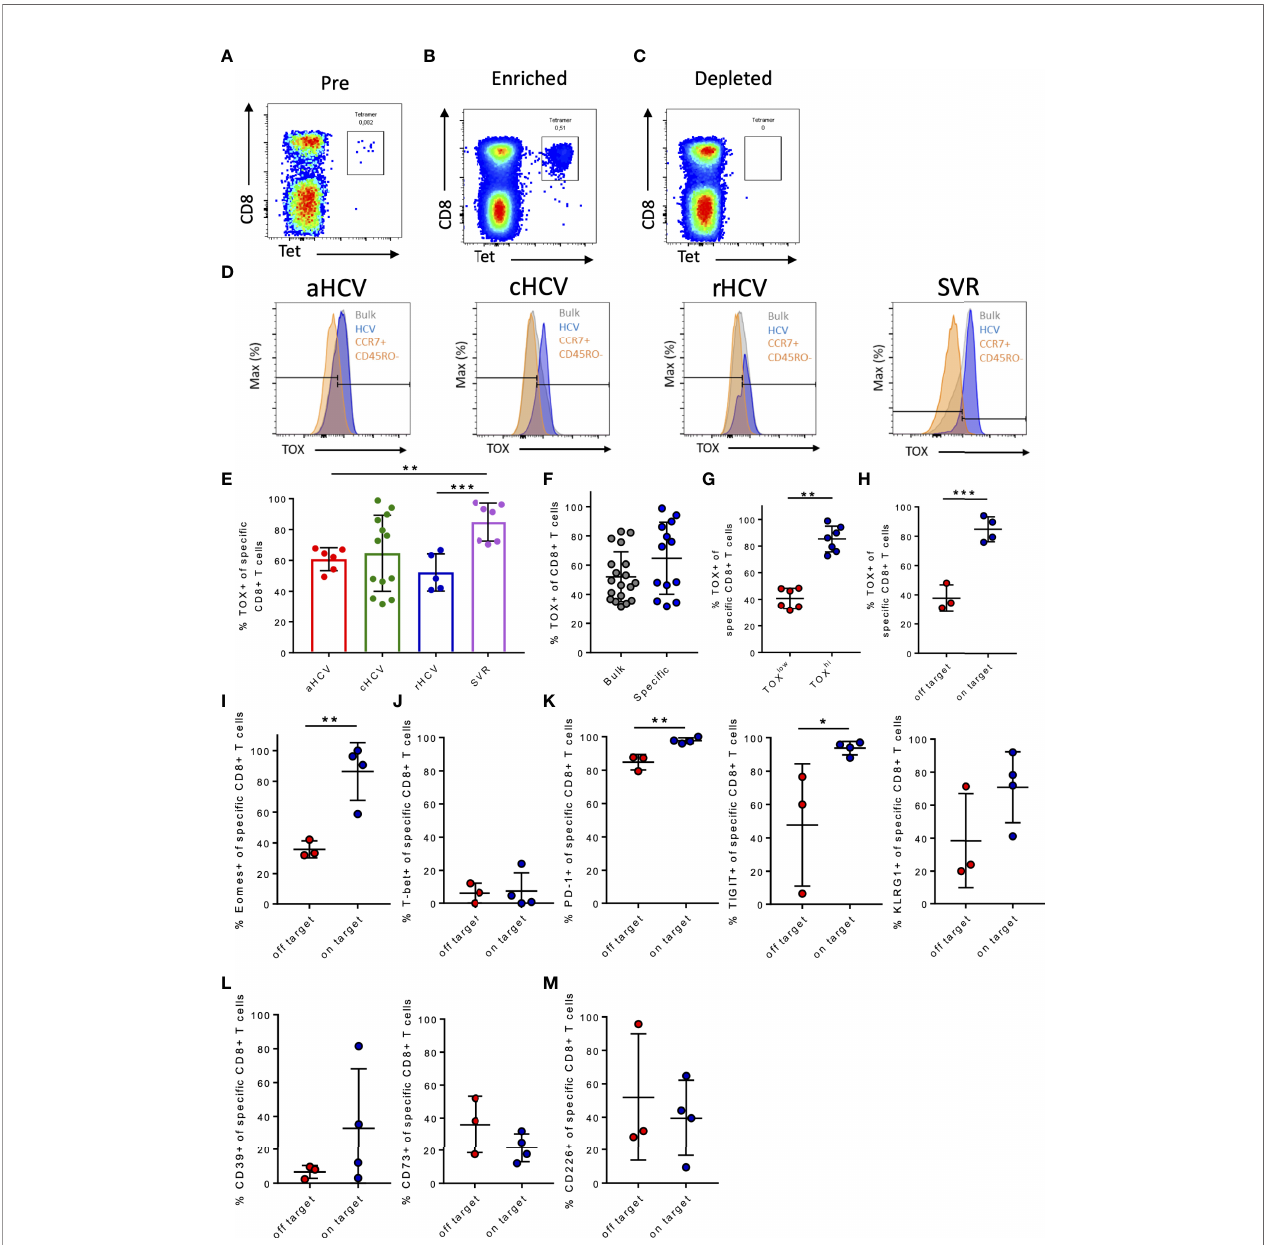
FIGURE 1 | (A – M) Frequency of TOX+ virus-speci fi c CD8+ T cells in chronic hepatitis C infection and comparison to the immunological phenotype of patients with on- target T cells and off-target T cells to the corresponding targeted antigen. (A – C) Representative dot plots of PBMC gated on CD3+ T cells before (Pre), after (Enriched), and without enrichment (Depleted). (D) Representative gating of marker TOX in acute HCV (aHCV), chronic HCV (cHCV), spontaneously resolved hepatitis C (rHCV), and successfully treated patients with a sustained virologic response (SVR) (blue: HCV-speci fi c CD8+ T cells; gray: CD8+ T cells in the bulk population; orange: CCR7+ CD45RO- CD8+ T cells). (E) Frequencies of TOX+ virus-speci fi c CD8+ T cells at the different stages of HCV infection. (F) Frequencies of TOX+ CD8+ T cells in cHCV in the bulk population and in HCV-speci fi c CD8+ T cells. (G) Frequencies of TOX+ virus-speci fi c CD8+ T cells divided into patients with low and high frequencies of TOX+ HCV-speci fi c CD8+ T cells. (H) Frequencies of TOX+ virus-speci fi c CD8+ T cells in chronic hepatitis C. (I) Frequencies of Eomes+ virus-speci fi c CD8+ T cells in chronic hepatitis C. (J) Frequencies of T-bet+ virus-speci fi c CD8+ T cells in chronic hepatitis C. (K – M) Frequency of PD-1+, TIGIT+, KLRG1+, CD39+, CD73+, and CD226+ virus-speci fi c CD8+ T cells in chronic hepatitis C. Data are shown as mean ± SD, where *, **, and *** indicate P values <0.05, <0.01, and